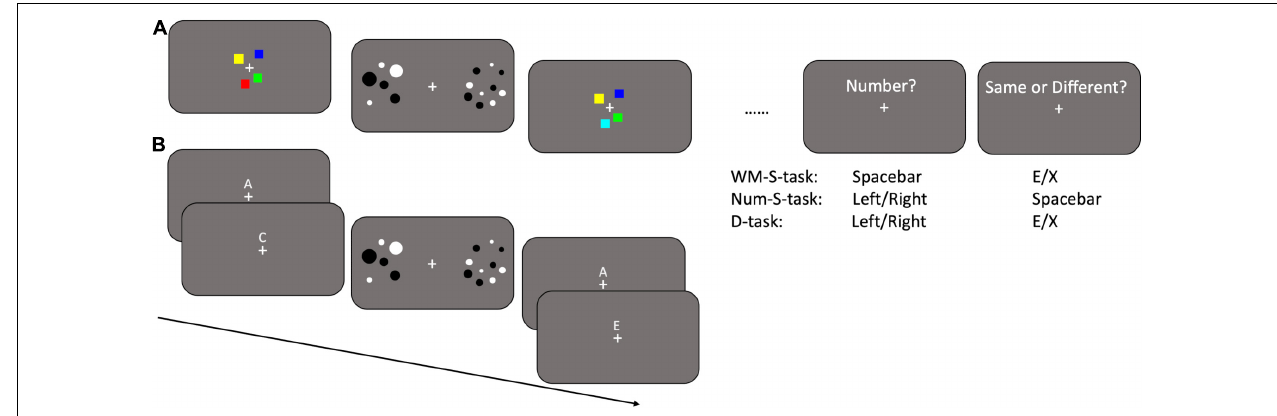
FIGURE 1 | Paradigm and stimuli. Representation of the stimuli used in the visuo-spatial single and dual tasks (A) and verbal single and dual tasks (B) . Possible responses in the single working memory tasks (WM-S-task), single numerosity (Num-S-task) and dual (D-task) tasks are shown on the right below the relative